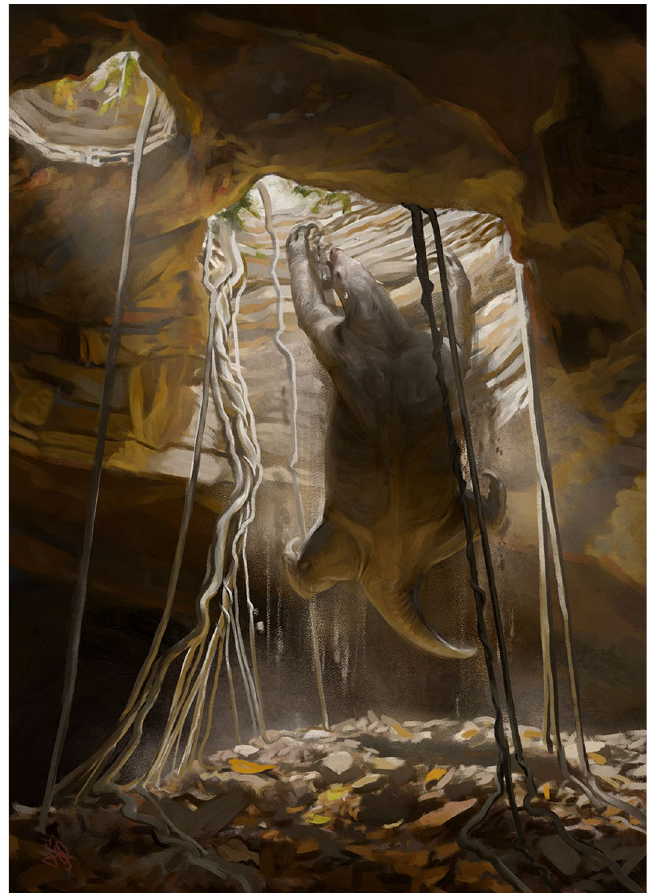
Figure 4. Artistic reconstruction of the suggested fall of the individual Eremotherium laurillardi into the cave. Artwork by Júlia